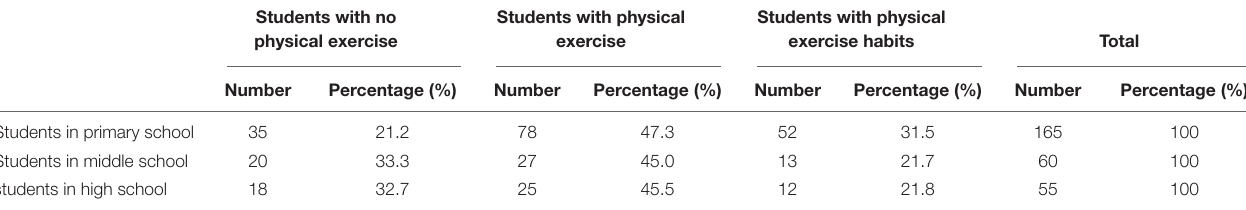
TABLE 7 | Distribution of physical exercise habits of primary and middle school students in different grades.